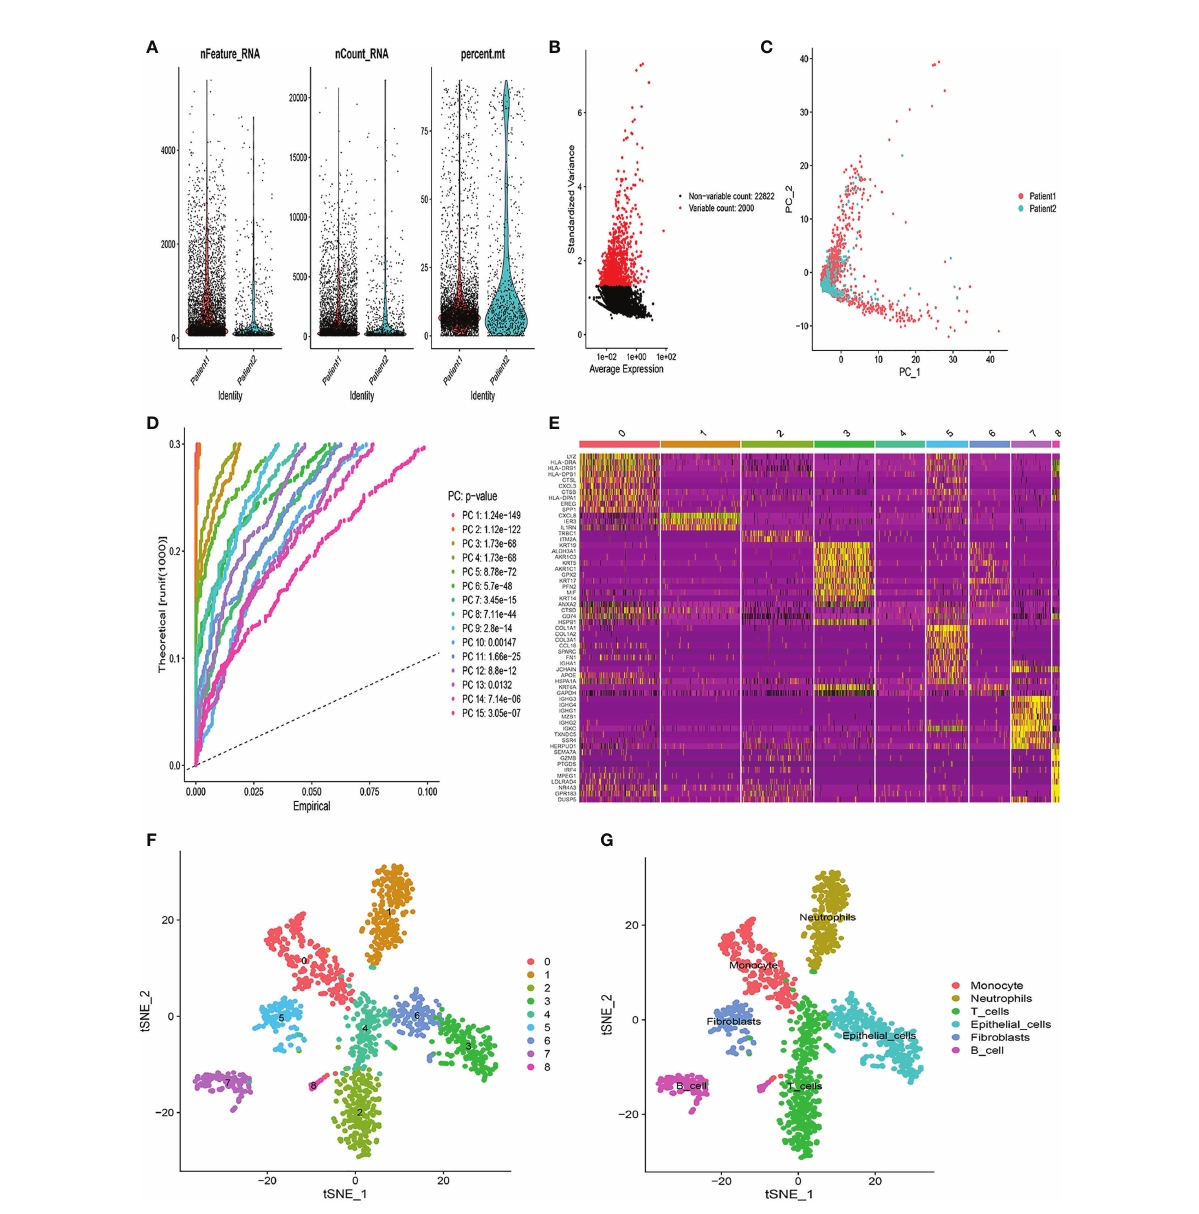
FIGURE 1 Identi fi cation of T-cell marker genes by scRNA-seq analysis. (A) Quality control of scRNA-seq data from two LUSC samples. (B) The variance plot showed 22,822 genes in all cells, red dots represent the top 2000 highly variable genes. (C) PCA was used for dimensionality reduction. (D) 15 PCs were identi fi ed based on P -value< 0.05. (E) The heatmap showed the relative expression of genes in 9 clusters. Yellow represents high expressed genes and purple represents low expressed genes. (F) 9 clusters were visualized based on the t-SNE algorithm. (G) Cell subpopulations identi fi ed by marker